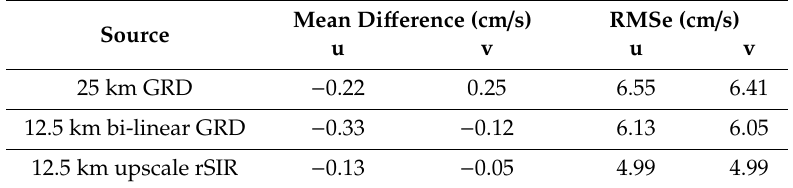
Figure 7. Arctic region 22 January 2014 sea ice motion field from 37H TBs for ( a ) 25 km GRD, ( b ) 12.5 km bi-linearly interpolated GRD, and ( c ) 12.5 km upscaled rSIR. Buoy motions are overlaid in red. Table 2. Statistics of PM motions with IABP buoys (PM – buoy) for the standard 25 km GRD resolution, the GRD bi-linearly downscaled to 12.5 km, and the rSIR upscaled to 12.5 km. The nearest PM motion estimate for each buoy was used with a maximum distance of 50 km from the